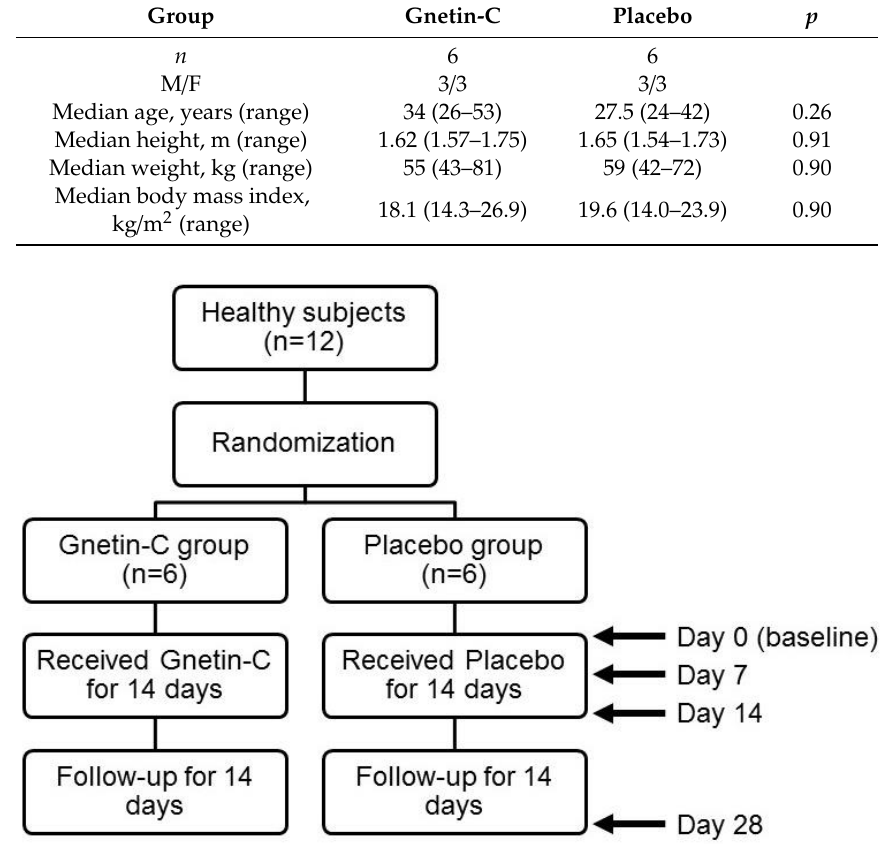
Figure 1. Flow diagram of the study.